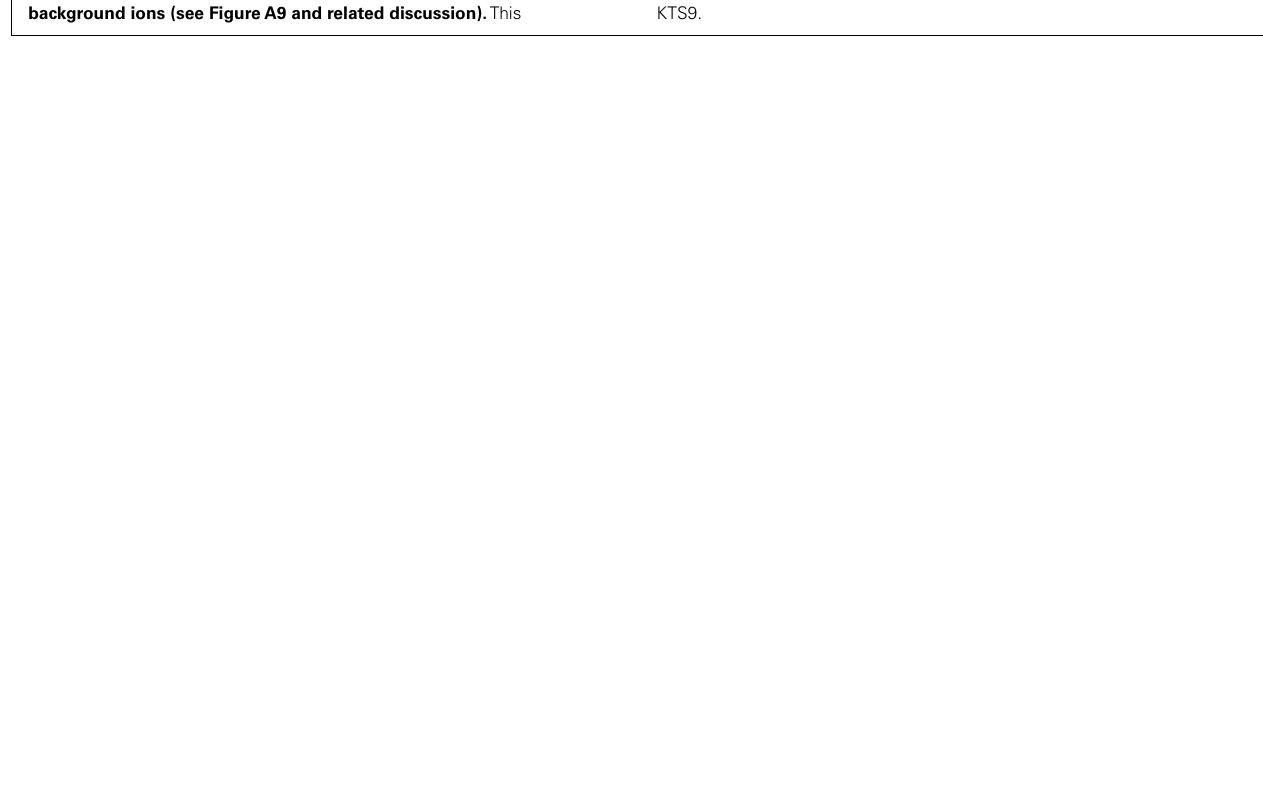
FIGUREA10 | Overall HLA-A2 peptide recovery is marked by a “hump” in the m / z range from 450 to 550 due to doubly charged peptide molecular ions relative to singly charged background ions (see FigureA9 and related discussion). This